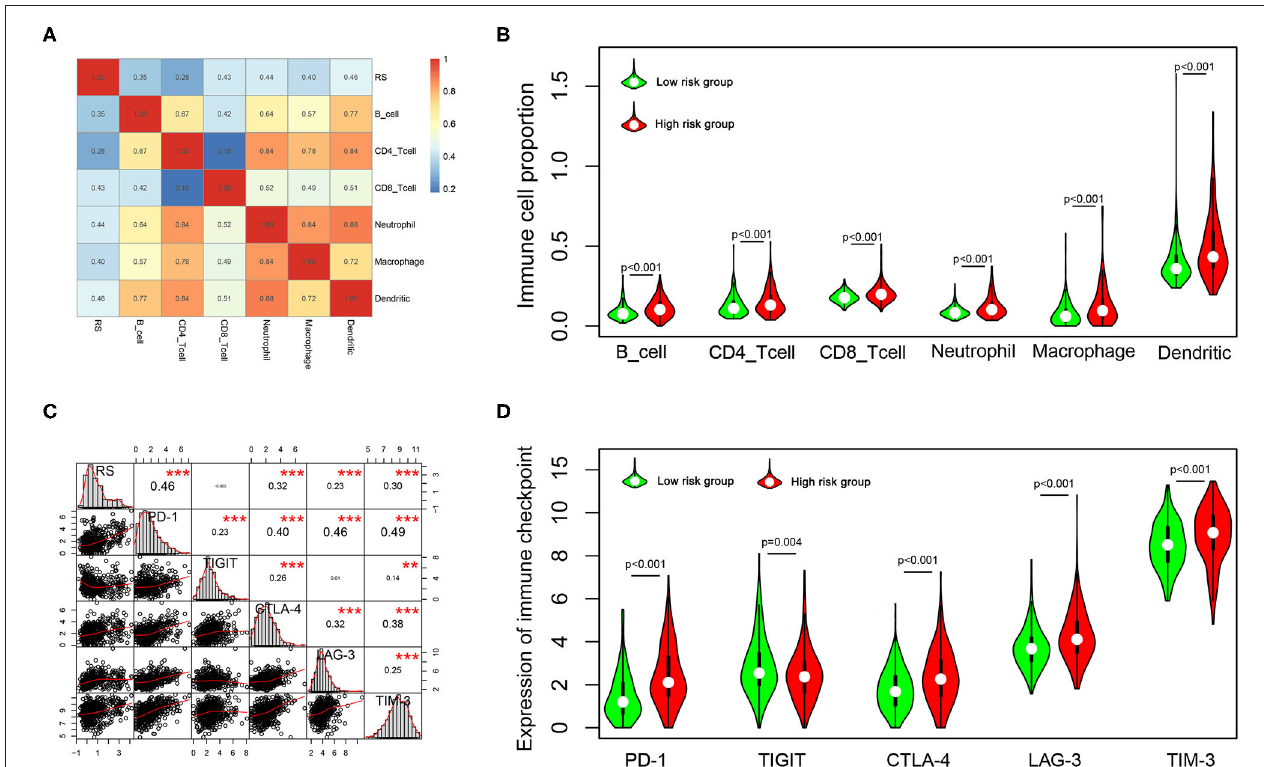
FIGURE 8 | Correlation of the risk score with infiltrating immune cell proportions and immune checkpoints. (A) Correlation of the risk score with infiltrating immune cell proportions. Pearson’s correlation coefficient values are shown in the heatmap. (B) Violin plot showing the immune cell proportions between low- and high-risk patients. (C) Correlation of the risk score with the expression of crucial immune checkpoints. Pearson’s correlation coefficient values and level of significance were also showed. *** p < 0.001 and ** p < 0.01. (D) The expression of different immune checkpoints between the low- and high-risk patients is shown in the violin plot.